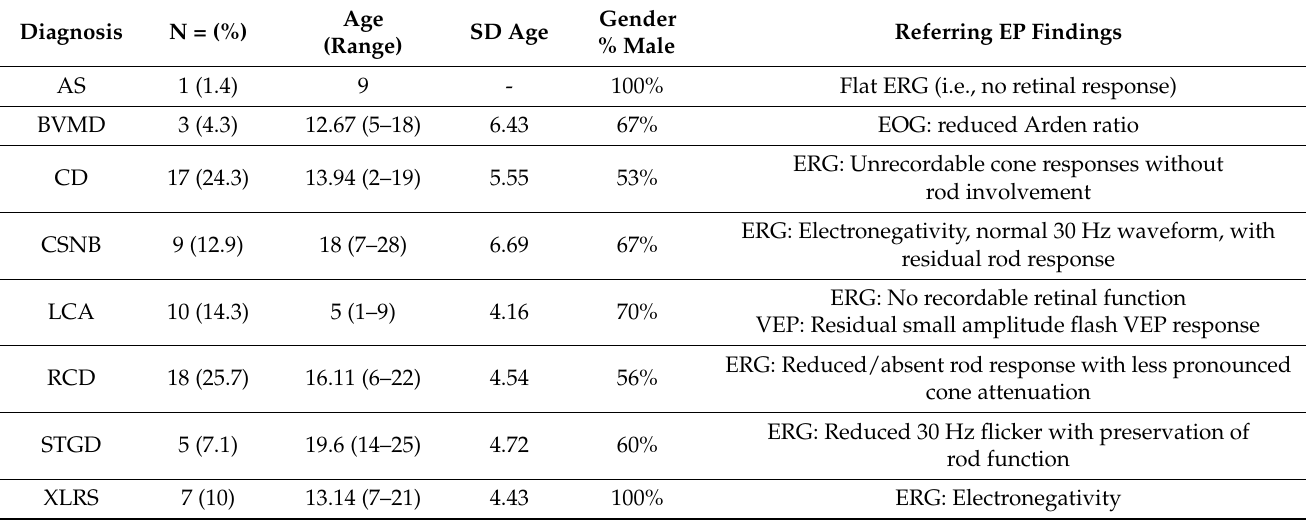
Table 1. Demographic information by clinical diagnosis (in alphabetical order).